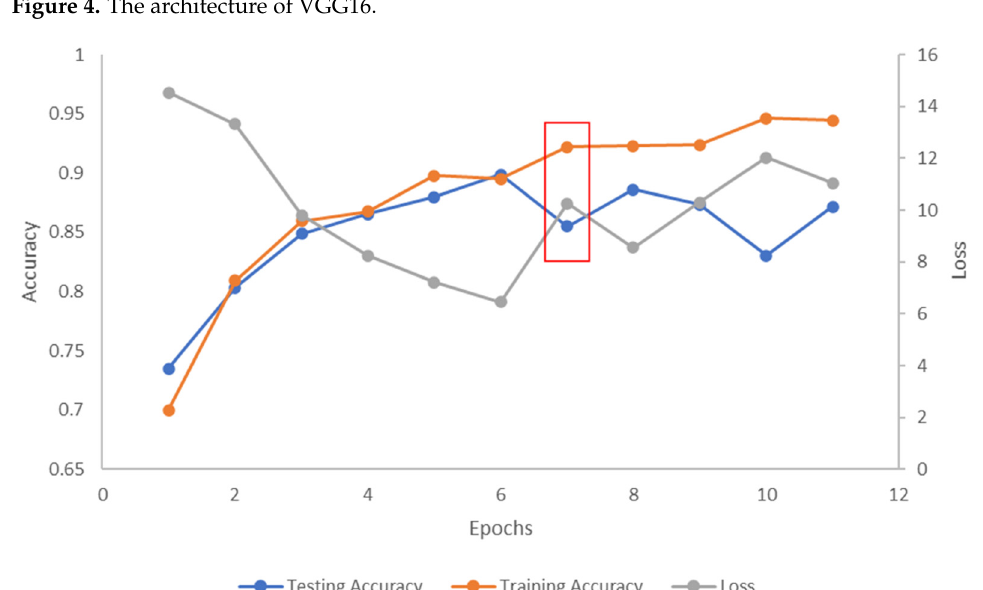
Figure 5. Graph of training accuracy, testing accuracy and loss versus epochs. The red box is the epochs after no improvement in the loss for five consecutive epochs.